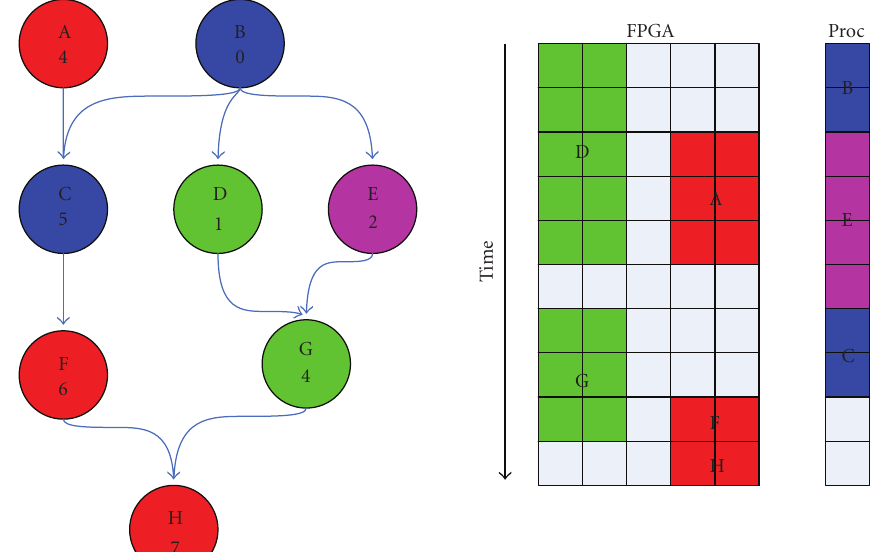
Figure 3: A scheduling example from Napoleon.